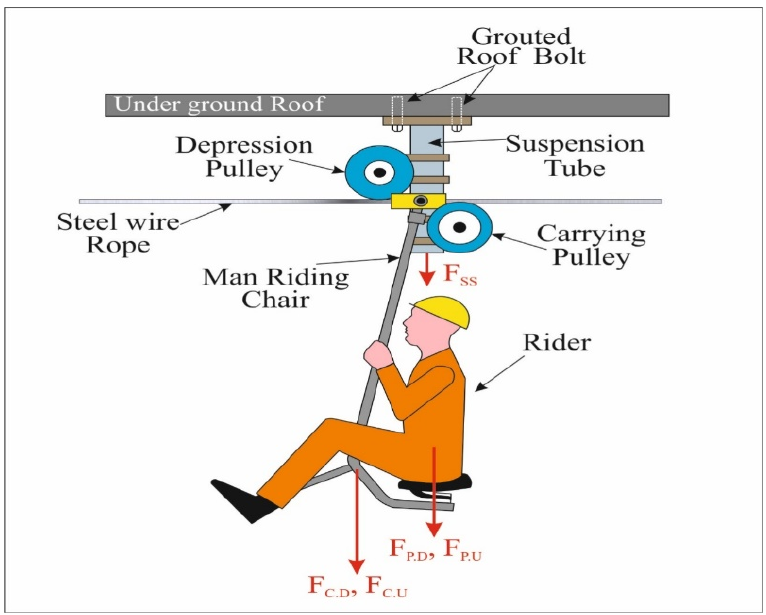
Figure 7. Suspension tube grouted with two number of roof